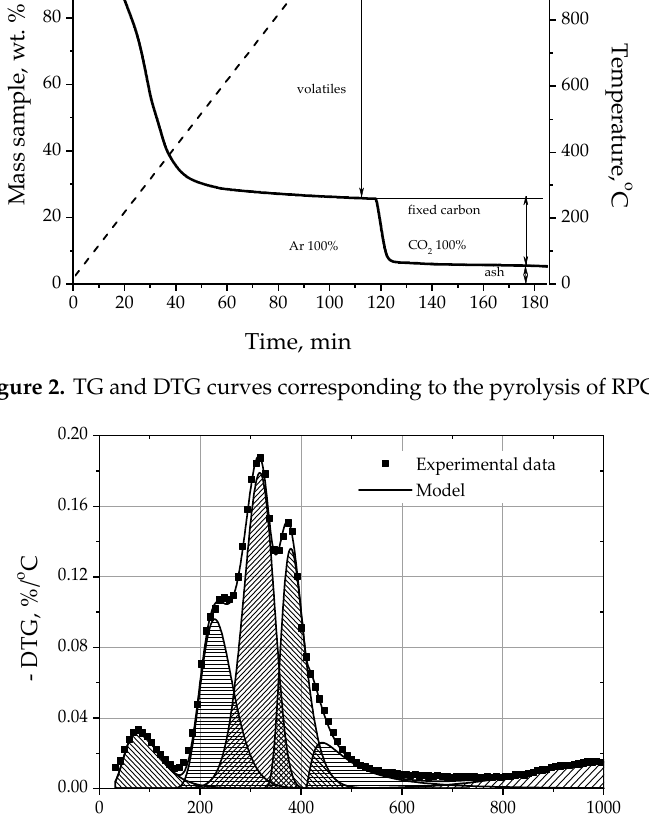
Figure 2. TG and DTG curves corresponding to the pyrolysis of RPC.